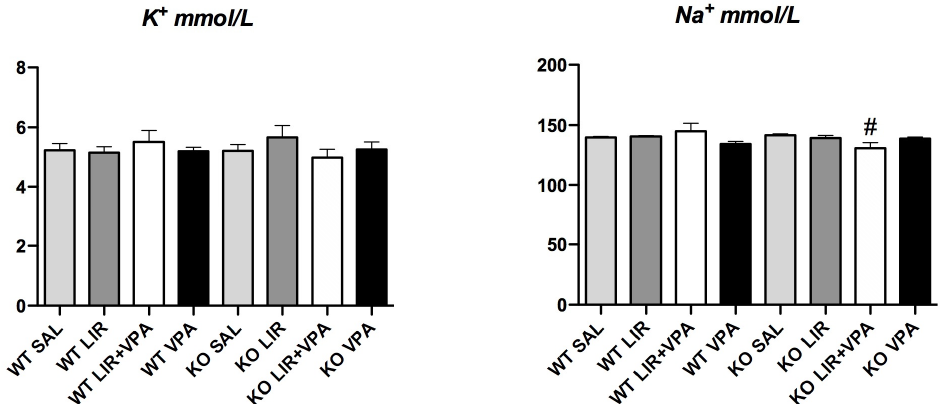
Figure 6. Na + and K + levels measured in 3.5–4-month-old animals’ blood serum after 8 days of treatment with liraglutide (LIR), valproate (VPA), liraglutide + valproate (LIR + VPA), or saline (SAL). Electrolyte levels were determined using Ion-Selective Electrode (ISE) indirect Na-K-Cl for Gen.2 package insert of the Roche/Hitachi cobas c systems (Roche Diagnostics) and are presented as mmol/L. Data were compared using factorial ANOVA followed by Fisher’s LSD post hoc tests; # p < 0.05 compared to KO vehicle (SAL) group. The data are presented as the mean ± SEM, n = 6–8 per group.